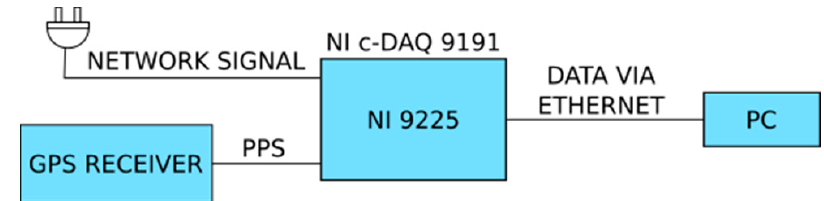
Figure 2. Scheme of the measurement chain. Network signal and GPS-PPS signal are acquired with the DAQ card (NI 9225) inside the chassis (c-DAQ-9191). It processes them and sends data to the PC via Ethernet.